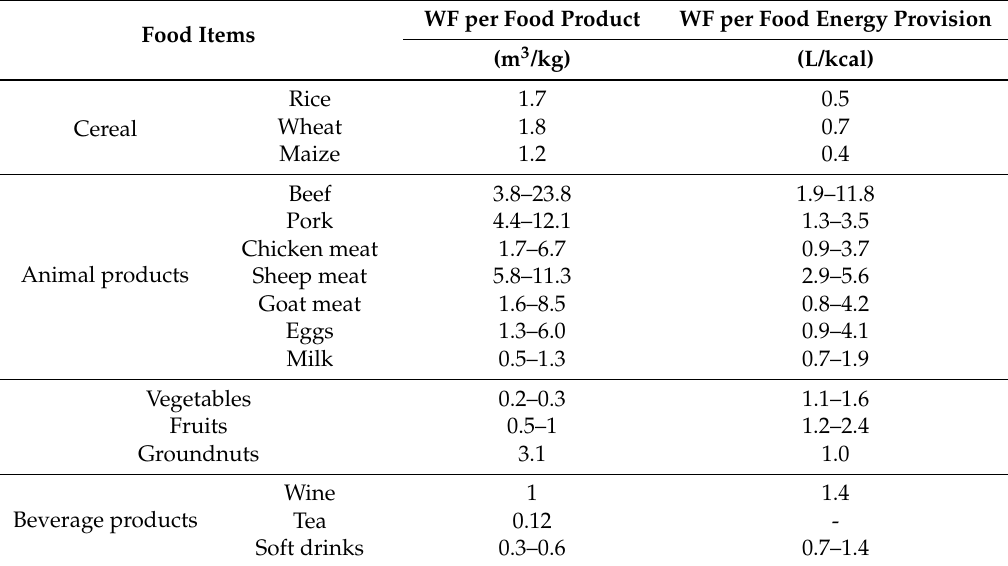
Table 2. Water footprint (WF) of main food